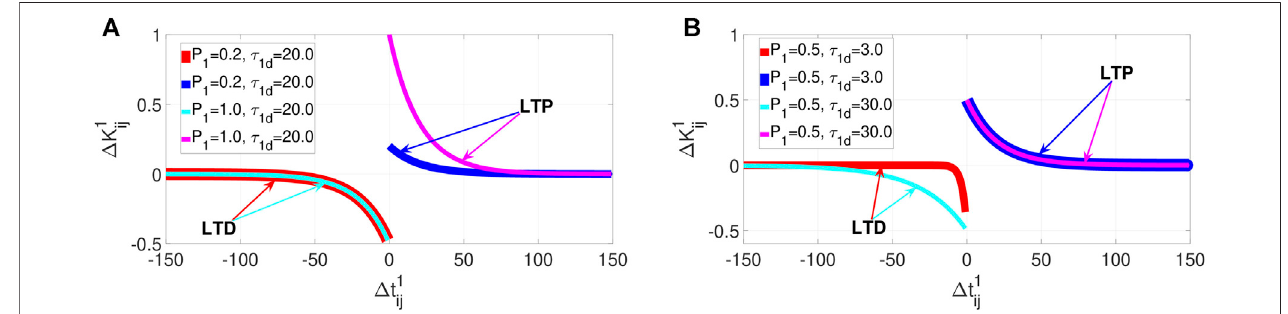
FIGURE 1 | Time windows for an asymmetric Hebbian eSTDP learning rule. Plot of synaptic modi fi cation Δ K 1 ij versus Δ t 1 ij ((cid:1) t ( post ) i − t ( pre )